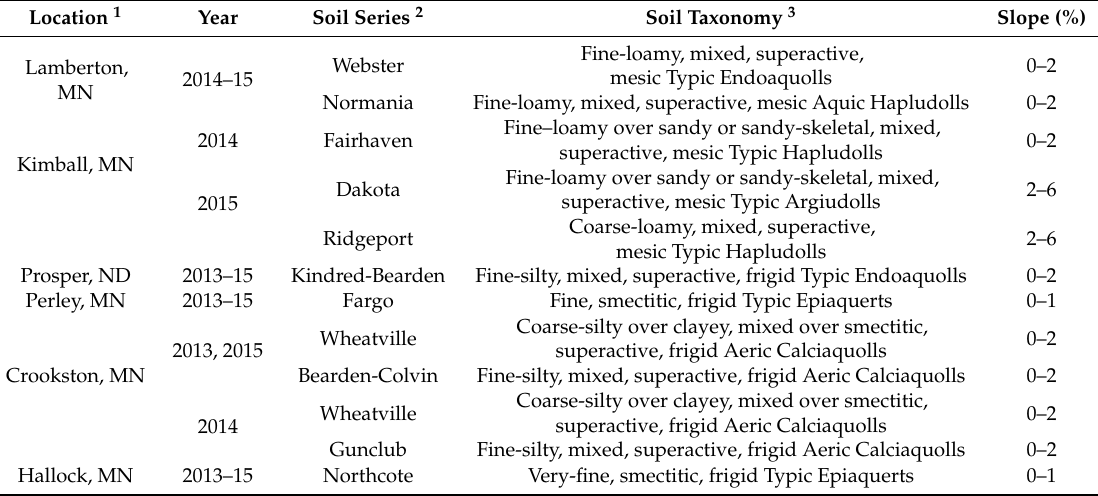
Table 1. Soil series, taxonomy, and slope at 2013–2015 experiment locations.